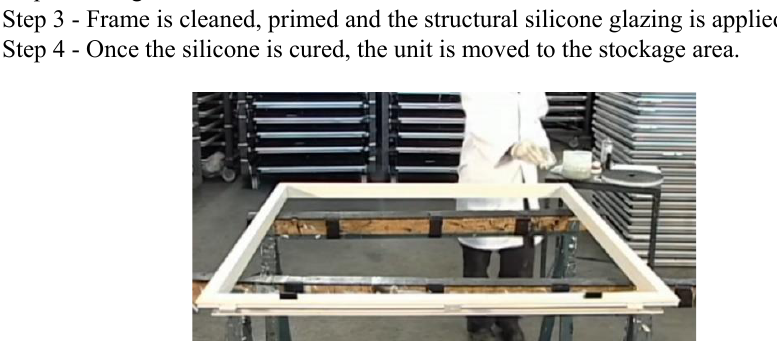
Fig. 1 Step 1 – Frame is positioned horizontally on a working